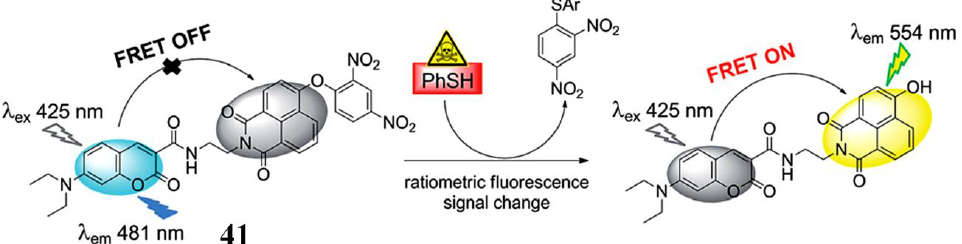
Figure 17. Structure and reaction of probe 41 with PhSH. Reproduced with permission from Reference [109]; copyright Royal Society of Chemistry.